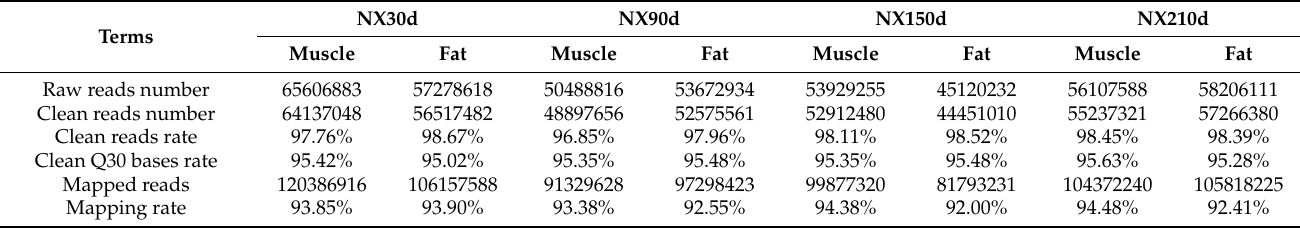
Table 1. Sequencing basic data of four different developmental stages of Ningxiang pig two